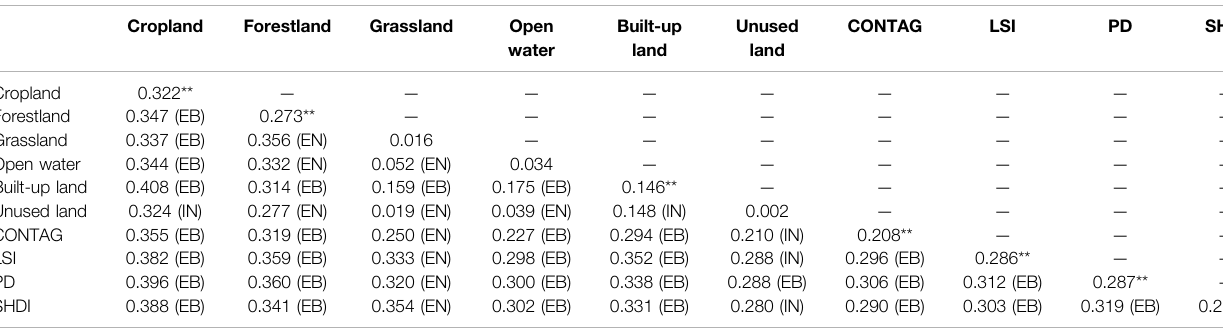
TABLE 4 | Results of factor and interaction detector for LST.